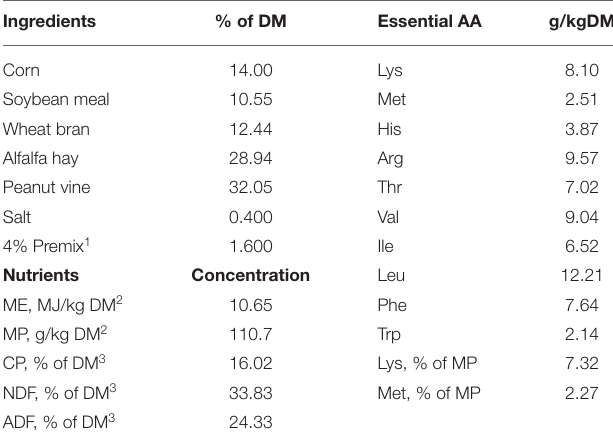
TABLE 1 | Ingredients, nutrients, and essential amino acid (AA) compositions of the pelleted diet.